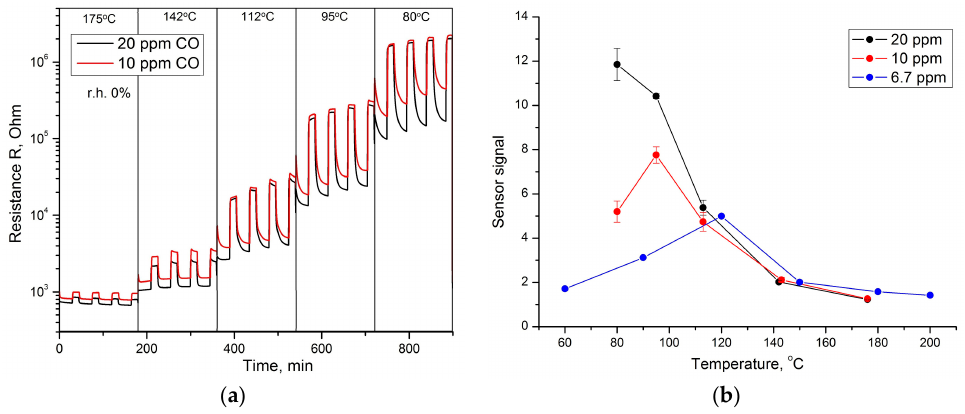
Figure 7. ( a ) Electrical response of Co 3 O 4 to the periodic change of gas phase composition from dry air (30 min) to CO/air (15 min); ( b ) sensor response of the Co 3 O 4 to CO (0% r.h.) as a function of temperature.